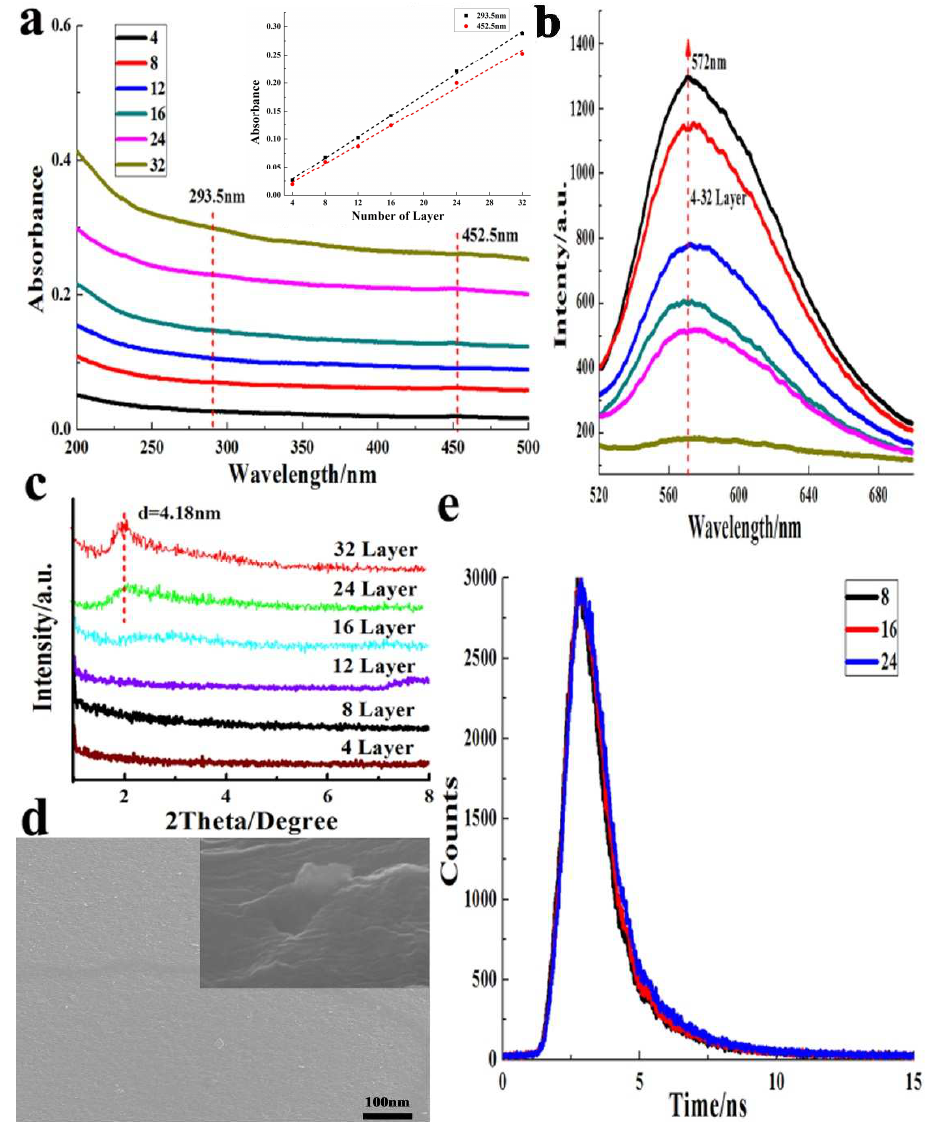
Figure 2. Characterization of (MMT/APPV@PVA) n (MA( n ) films) ( a ) UV-vis absorption spectra (the inset shows the absorbance at 293.5 nm and 452.5 nm increasing linear relationship; ( b ) fluorescence spectra; ( c ) Small angle X-ray Diffractometer (XRD) patterns; ( d ) Scanning Electron Microscope (SEM) images of the thin films surface, and the inset show the thin films’ cross sections; ( e ) Fluorescence decay